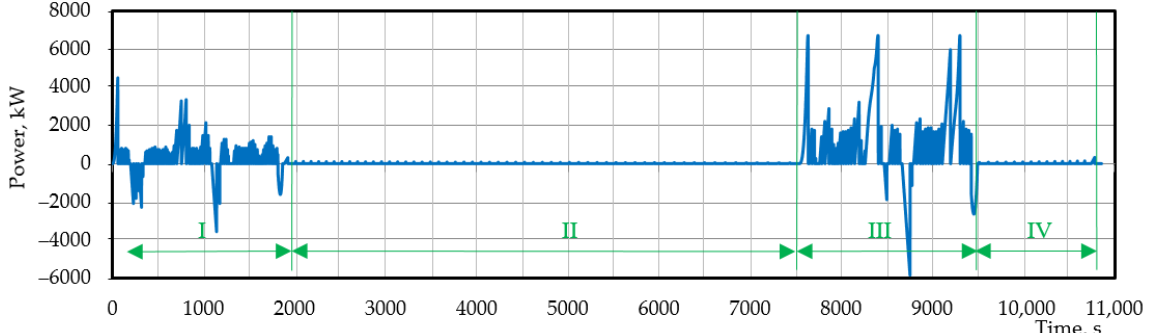
Figure 3. Traction characteristics of the electric locomotive ( a ) and profile of the track section ( b ).